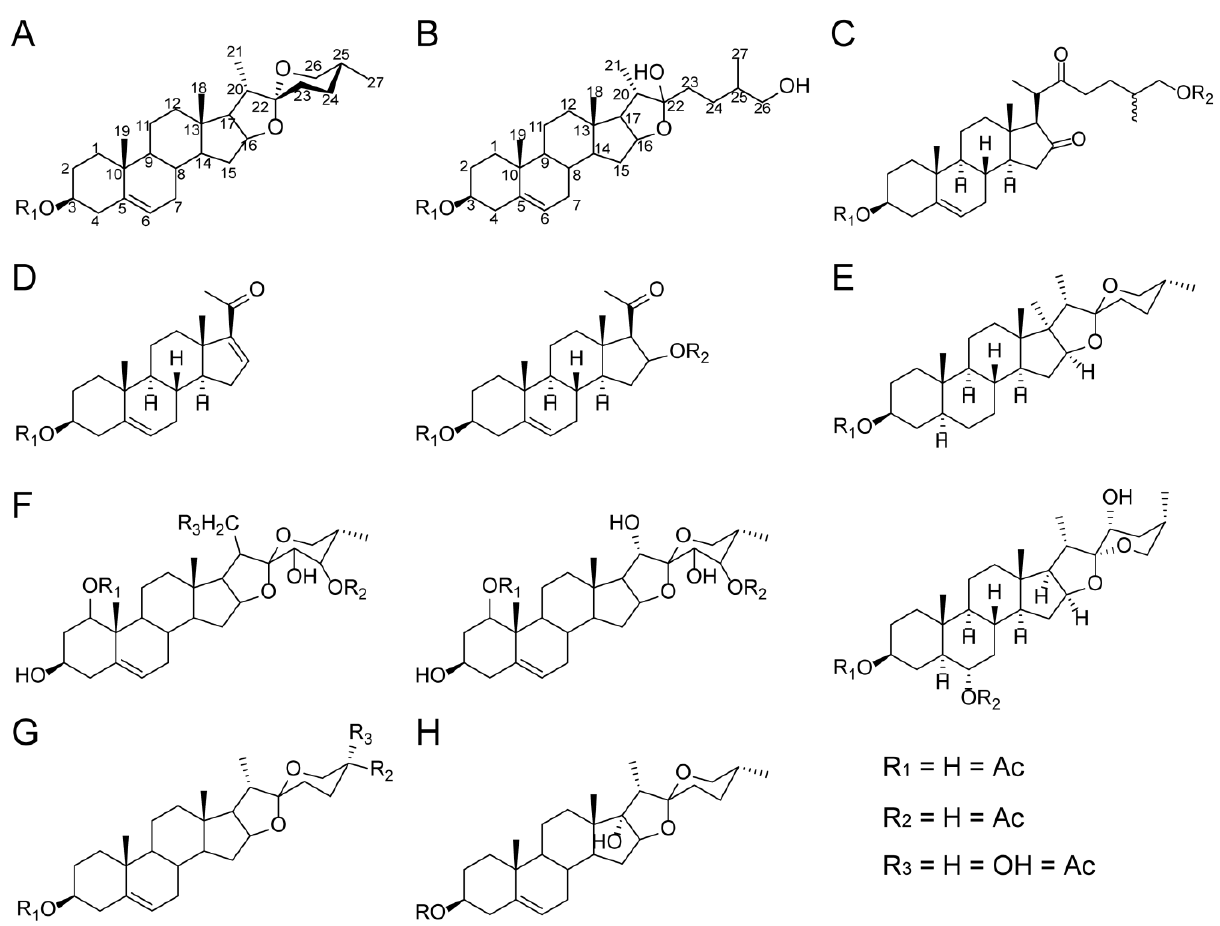
Figure 1. Structural diagrams of eight types of steroidal saponins isolated from plants. ( A ) Spirostanol saponins, ( B ) furostanol saponins, ( C ) cholestane saponins, ( D ) pregnane saponins, ( E ) isospirostanol saponins, ( F ) polyhydroxylated saponins, ( G ) pseudospirostanol saponins, and ( H ) pennogenin saponins. Furostanol and spirostanol saponins are the two most common types of steroidal saponins in plants, while other types of steroidal saponins are unique to different plants. Steroidal saponins have a wide range of functions and pharmacological activities due to their connections with different aglycone skeletons and different numbers of sugar chains, and there are also many different types of steroidal saponins in the same plant. Therefore, the distribution and existing forms of steroidal saponins in plants are diverse, and may also be related to the different functions of steroidal saponins in different plants.